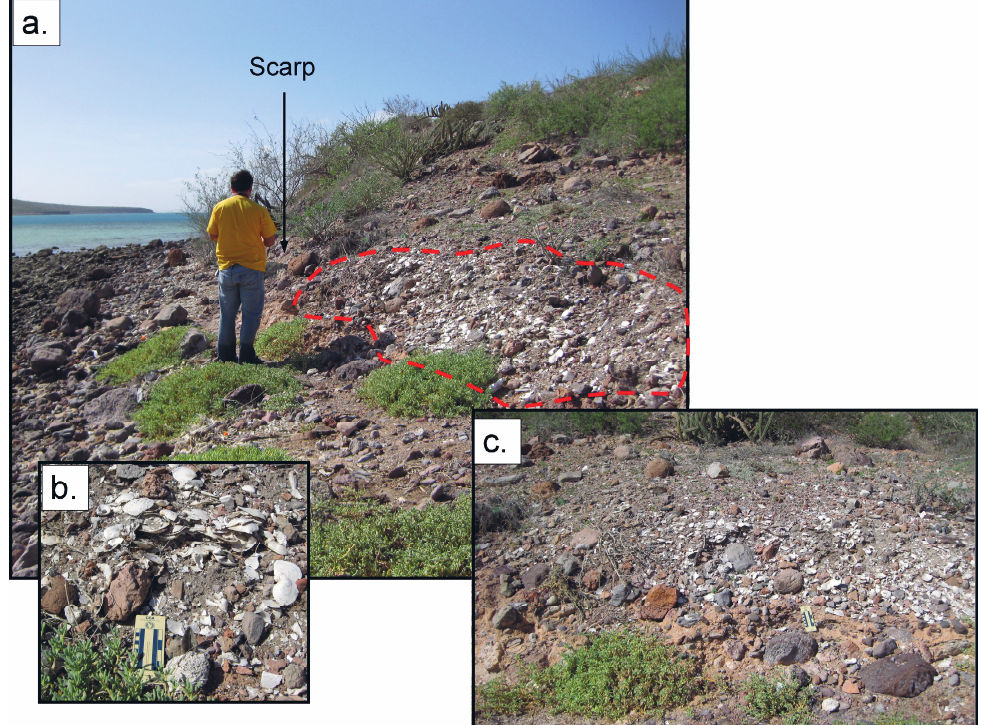
Figure 4. Area A. Area A is a small section of hillside ( a ) plastered with a shelly mixture of material, including angular boulders and imbricated shells ( b ); The layer sits above a reddish clay ( c